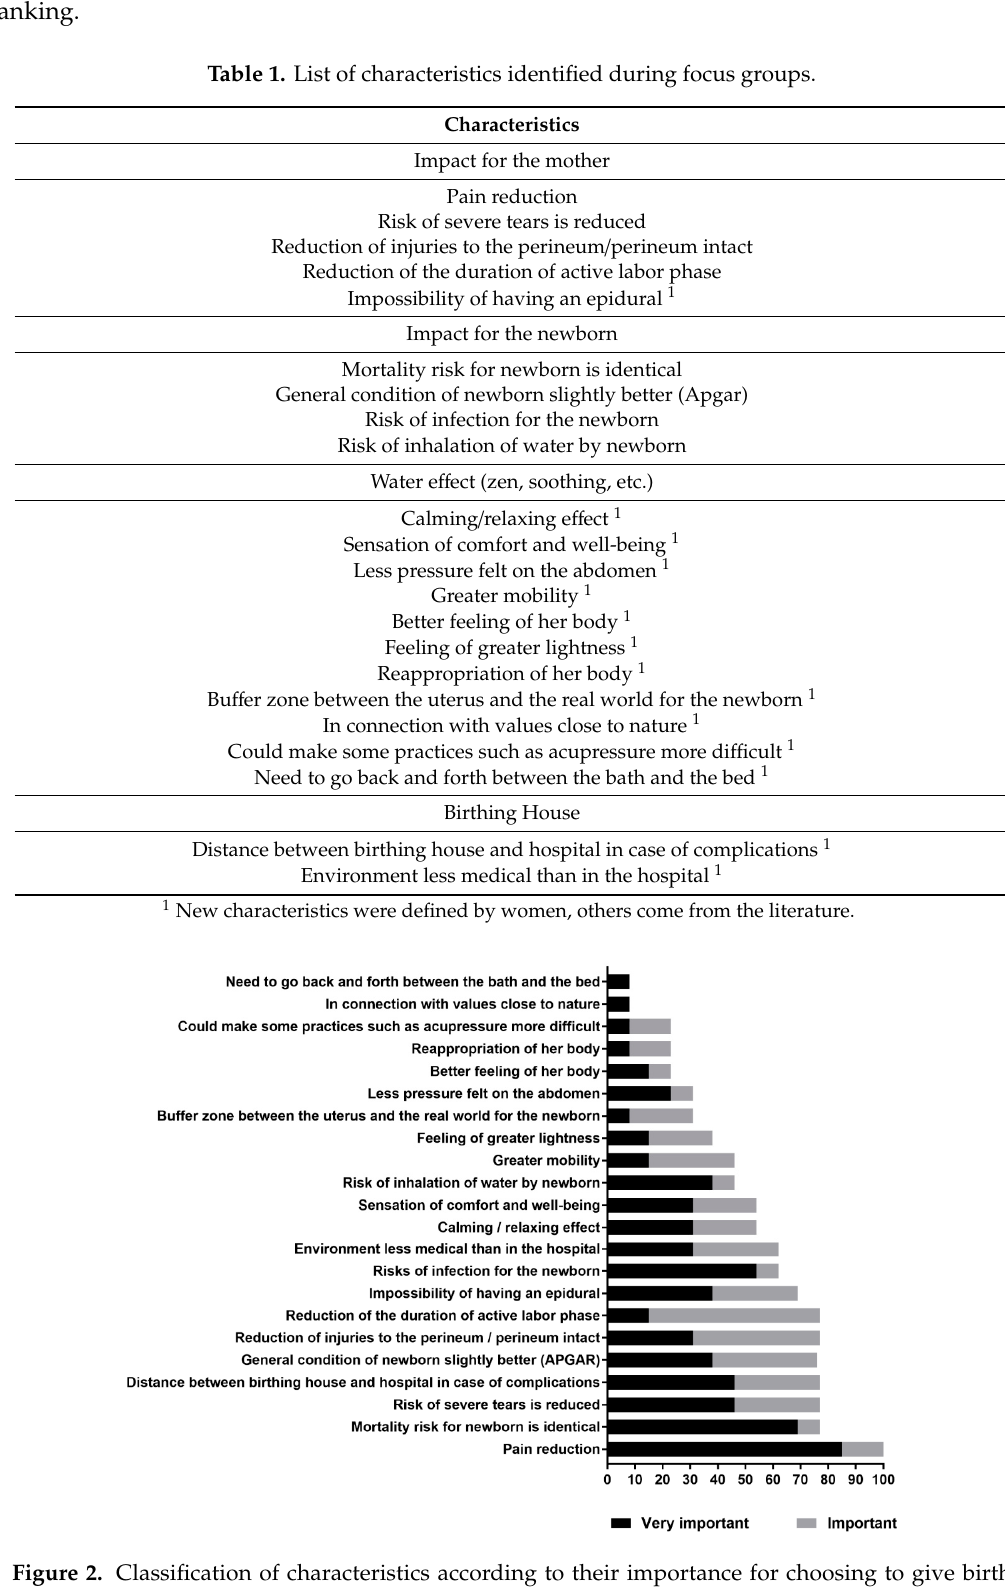
Table 1. List of characteristics identified during focus groups.